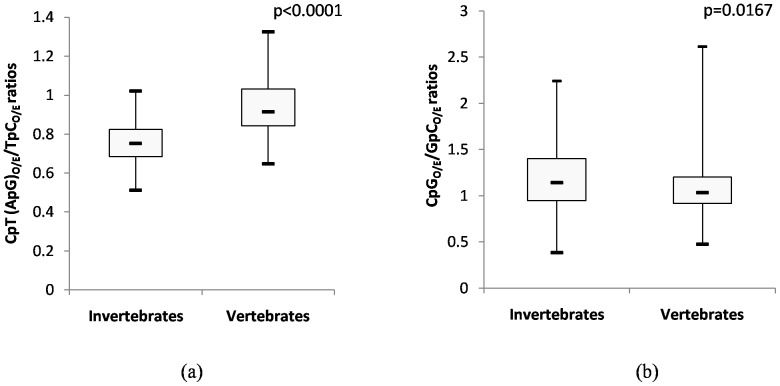
Invertebrate host-induced pressure is specific to CpT (and not TpC) and CpG (and not GpC) dinucleotides.(a) Box plot comparing the CpTO/E/TpCO/E ratios among large DNA viruses infecting invertebrates and vertebrates. The CpTO/E/TpCO/E ratios were significantly lower in large DNA viruses infecting invertebrates as compared to those infecting vertebrates (0.76±0.11 vs 0.93±0.14; P<0.0001) clearly demonstrating that CpT dinucleotides but not TpC dinucleotides are subjected to host-induced pressures. (b) Box plot comparing the relative CpGO/E/GpCO/E ratios dinucleotides among large DNA viruses infecting invertebrates and vertebrates. The CpGO/E/GpCO/E ratios among large DNA viruses infecting invertebrates were significantly higher than those infecting vertebrates (1.17±0.32 vs 1.06±0.28; P = 0.01), demonstrating that CpG dinucleotides but not GpC dinucleotides are subjected to host-induced pressures among large DNA viruses infecting invertebrate hosts.